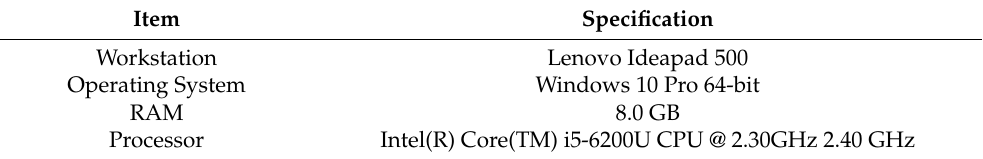
Table 7. The hardware specifications of the used work station in the experimental work.